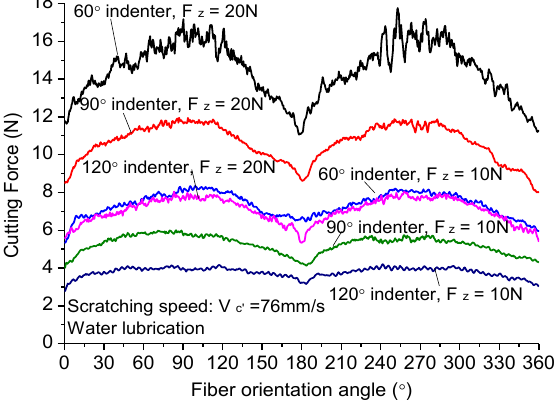
Figure 14. Scratching force varying with fiber orientation.